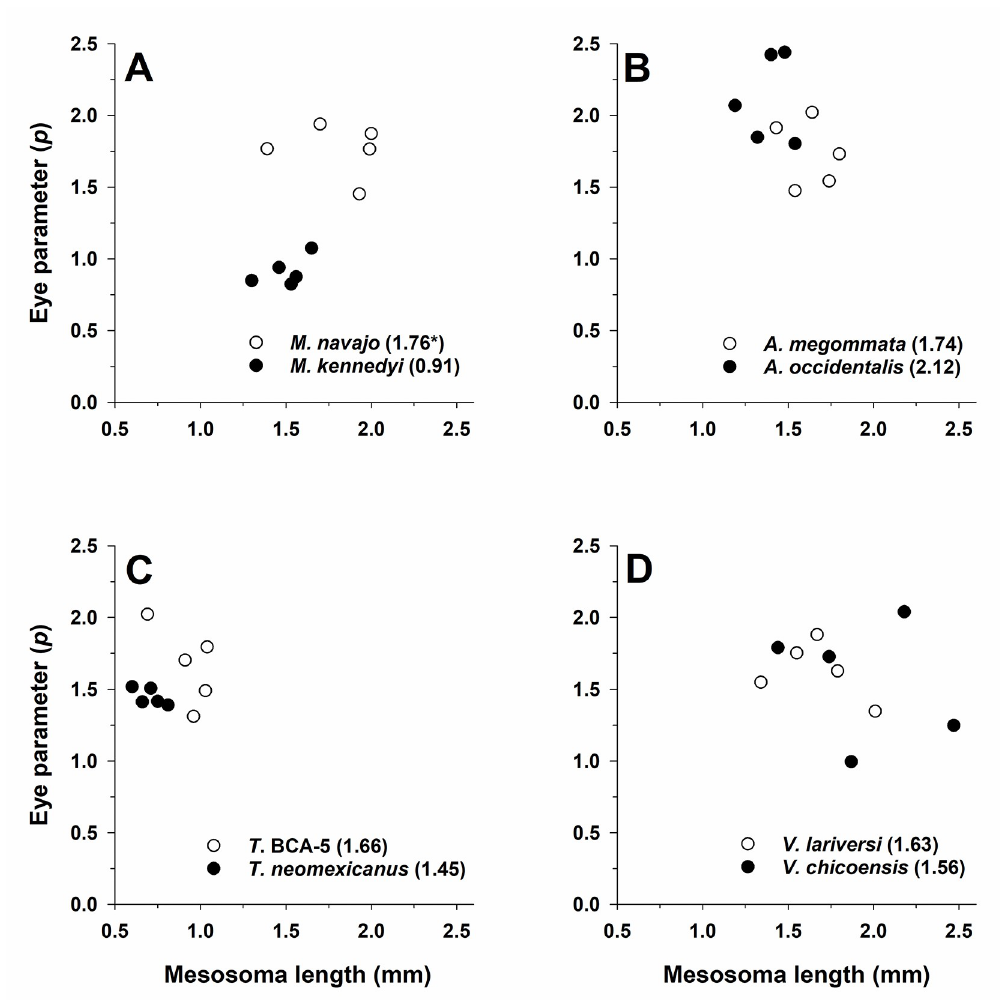
Fig 11. Eye parameter ( ρ ) for one pale (open circles and regular font) and one dark (filled circles and bold font) (see text) species in each of four ant genera: ( A ) Myrmecocystus , ( B ) Aphaenogaster , ( C ) Temnothorax , and ( D ) Veromessor . All plots have the same x-axis and y-axis scaling in order to visualize differences between light and dark species across genera. Mean p is given after each species name with an asterisk denoting the species with a significant larger p based on a t-test ( P < 0.05). The significant interaction of genus × activity period is shown by larger differences between light-colored and dark-colored species of Aphaenogaster compared to those in the other three genera. Sample size is n = 5 for each species. for Aphaenogaster , intermediate for Temnothorax and Veromessor , and lowest for Myrmeco- cystus (Tukey’s HSD test, P < 0.05; Fig 11). Mesosoma length was not an important covariate in the model (F = 1.6, P > 0.20). The ρ 1,31 was not positively or negatively correlated with body size for any of the examined species (Fig 11). Visual field span. The ANCOVA for visual field span was significant for genus (F = 3,32 53.6, P < 0.001), activity period (F = 151.7, P < 0.001), and the interaction of 1,32 genus × activity period (F = 14.8, P < 0.001). Visual field span was greater for pale 3,32 (mean = 98.8 o ) than for dark species (mean = 73.0 o ), and the significant genus × activity period interaction indicated that differences between the visual field of pale and dark species were larger in some genera, e.g., Aphaenogaster , than others (Fig 12). Though not always signifi- cantly different, pale species had a larger mean visual field in all four genera ( Myrmecocystus t-